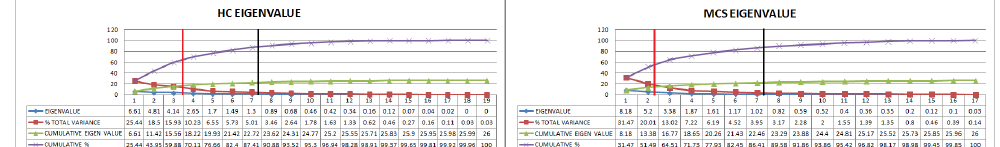
Figure 4. Scree plot depicting HC (on the left) and MCS (on the right) eigenvalues, percentage of total variance, cumulative eigenvalues and cumulative percentage of total variance. Vertical black rod indicates numbers of principal components resulting from Kaiser/Guttman criterion and vertical red rod indicates number of principal components needed to overcome 50% of total